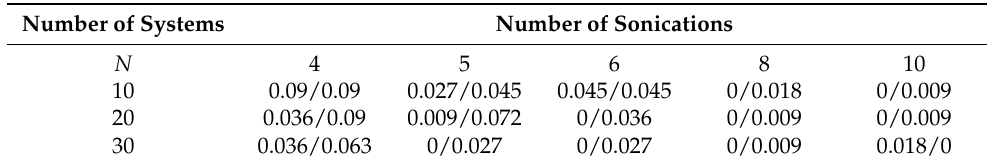
Table 4. Average percentage of non-treated/mistreated area from 15 independent runs as a function of the number of systems N and the number of